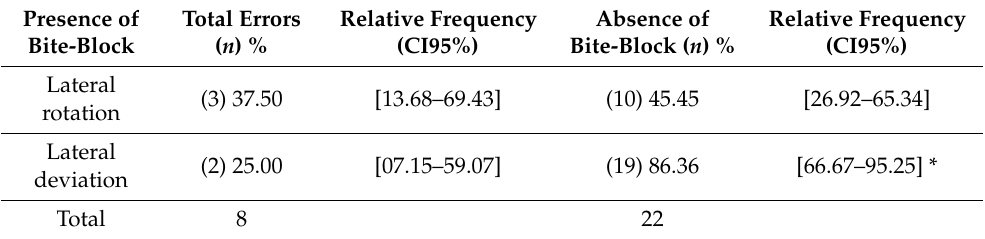
Table 3. Lateral head positioning errors concerning the use of the